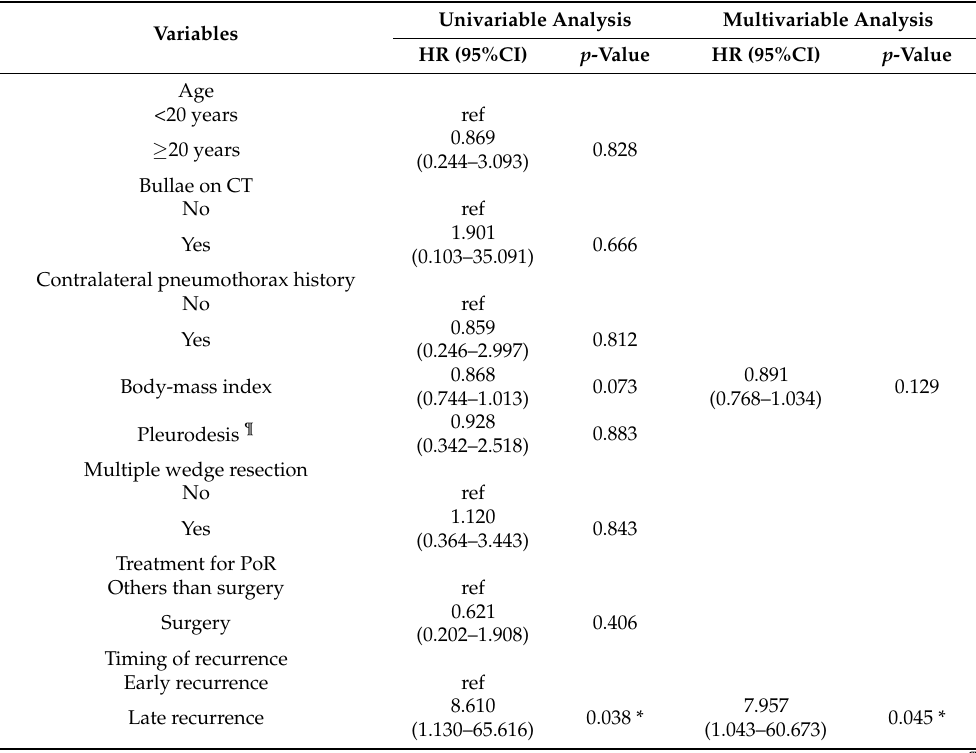
Table 3. Risk factor analysis for second recurrence (SR).